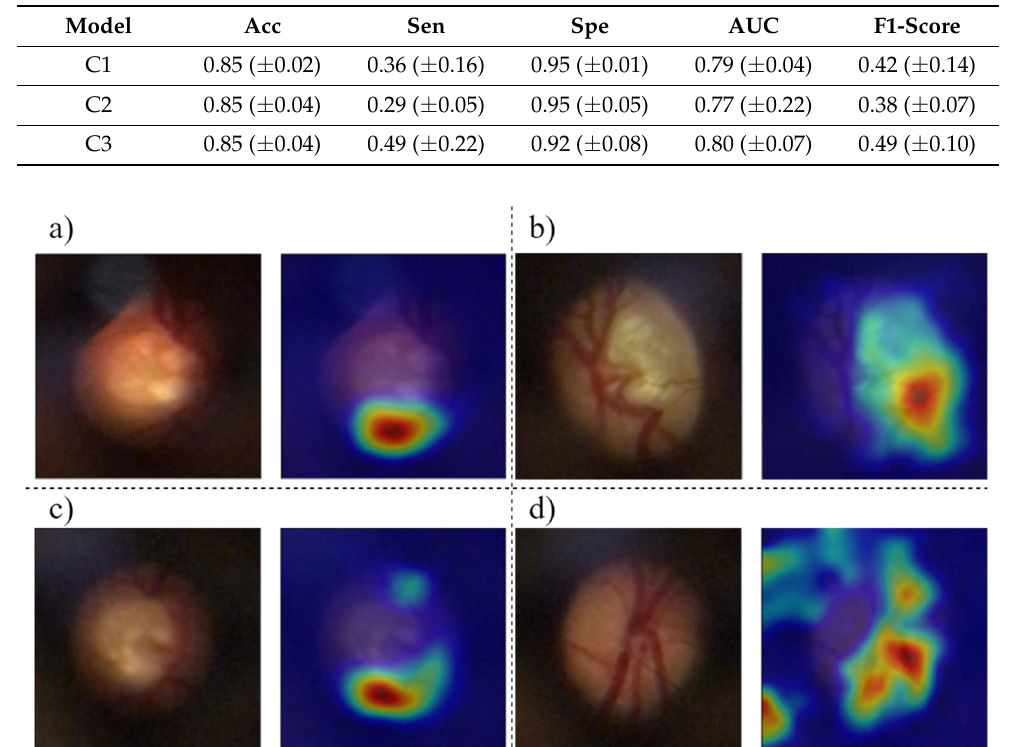
Figure 10. Activation maps for D-EYE images of the CV models. The importance is indicated by the emphasized shades in the following order, from the most important to the least important: red, orange, yellow, green, blue. All images report glaucoma cases ( a – d